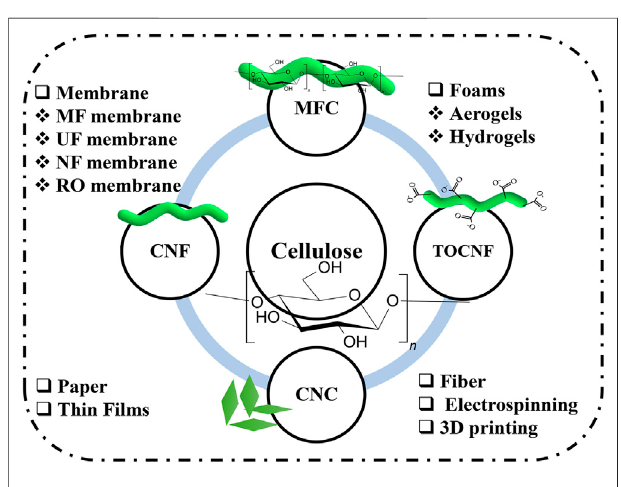
FIGURE 3 | Examples for cellulose derivatives and materials used in water treatment